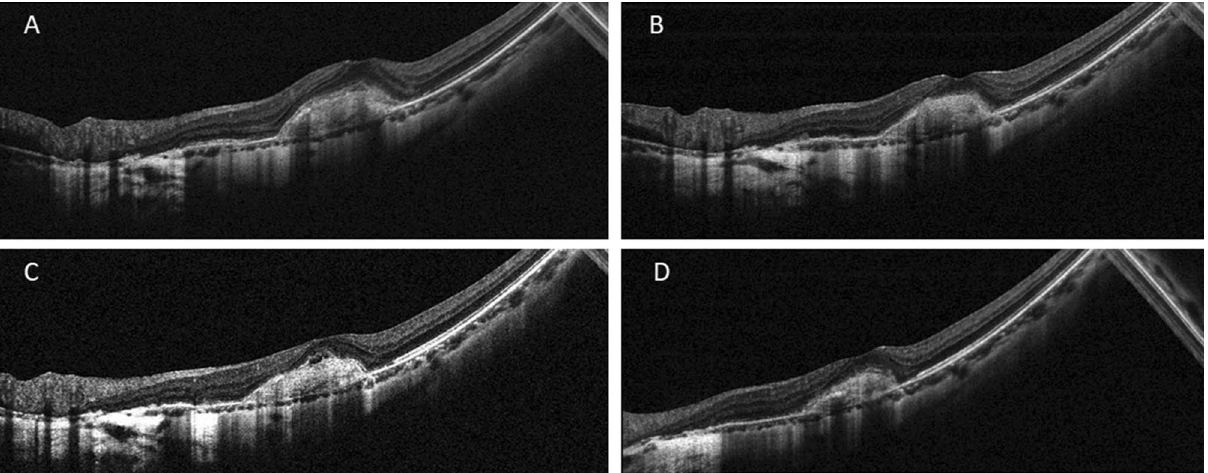
Figure 3. A 52-year-old male patient with mCNV. BCVA was 20/80 and CMT was 461um. ( A ) Subfoveal CNV with SRF and fuzzy border was shown on spectral-domain optical coherence tomography at baseline. ( B ) One month after 2 injections of Conbercept, subretinal fluid was absorbed and BCVA increased to 20/50. ( C ) Six month later, the patient suffered recurrence of CNV with increasing SRF and BCVA decreased to 20/80, thus one additional injection of Conbercept was given. ( D ) At one-year follow-up, CNV reduced with dry macula and vision improvement (BCVA was